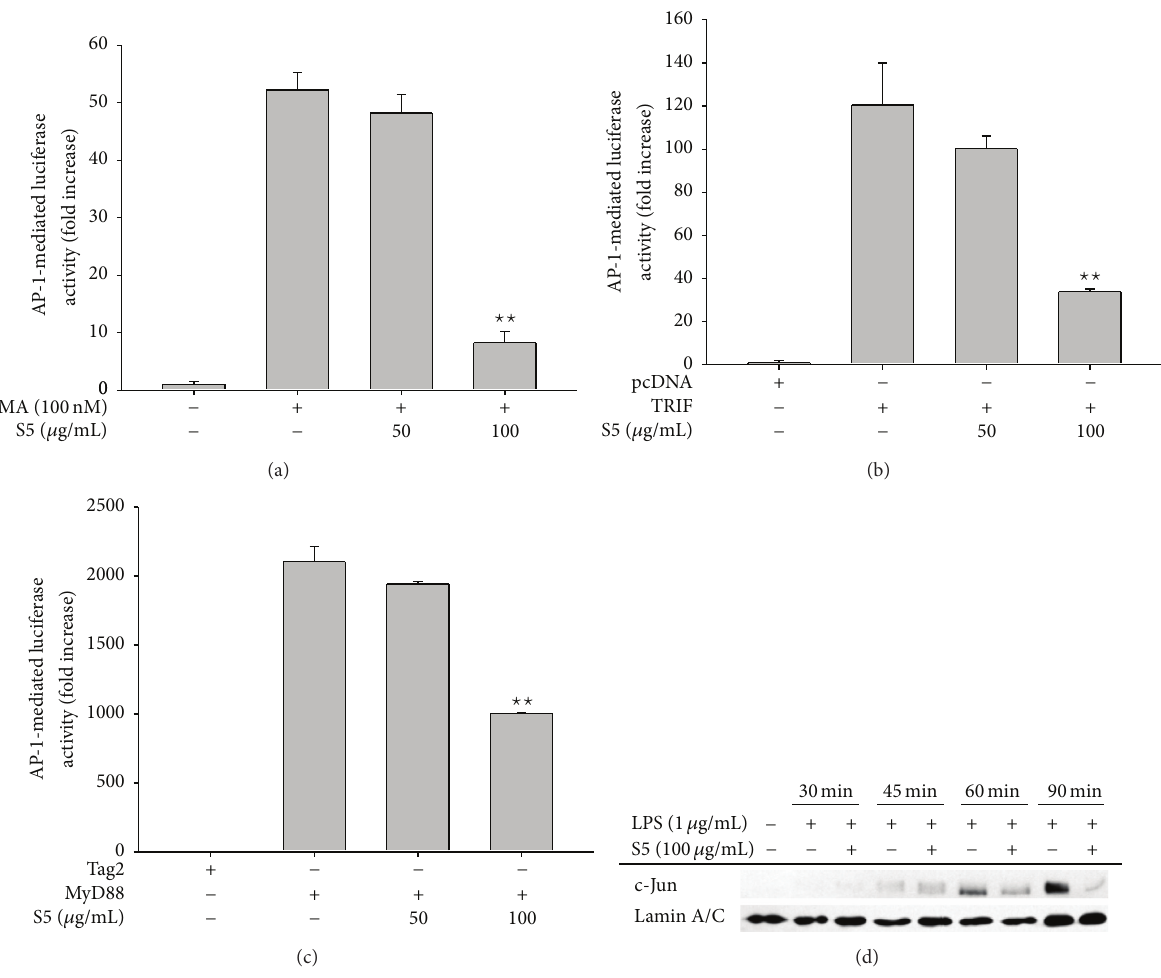
Figure 3: Effects of the S5 peptide on the activation of transcription factors. (a, b, and c) HEK293 cells that had been cotransfected with constructs driving the expression of AP-1-Luc, TLR adaptor molecules (MyD88 and TRIF), and 𝛽 -gal (as a control) were treated with the S5 peptide (0 to 100 𝜇 g/mL) in the presence or absence of PMA (100nM). The resultant luciferase activity was measured with a luminometer. (d) The nuclear translocation level of a transcription factor in the AP-1 family (c-Jun) was assessed by immunoblotting analysis with antibodies against total c-Jun. ∗ 𝑃 < 0.05 and ∗∗ 𝑃 < 0.01 compared with control